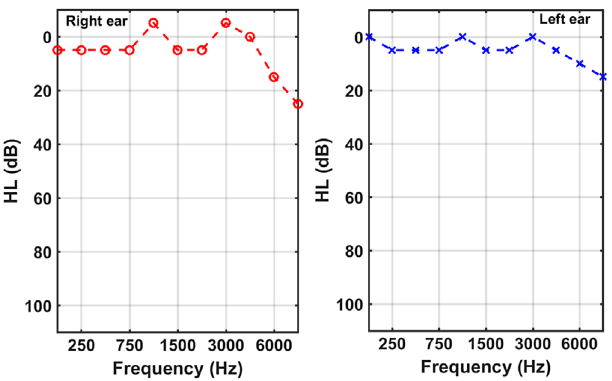
Figure 11. Right and left pure tone audiograms of a partici- pant #2.